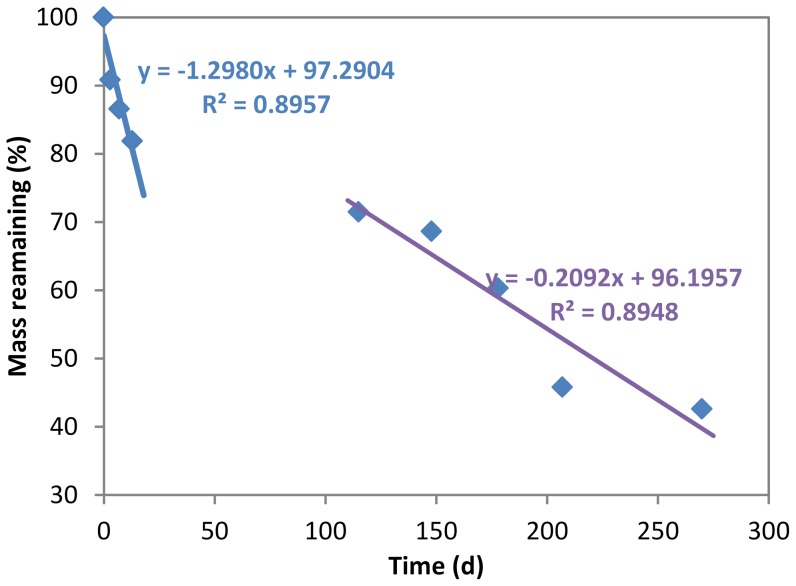
Detritus mass remaining of all the samples.Mean percentage of detritus mass remaining of all the samples during experimental period. The blue and purple solid lines are the linear regression lines for mass remaining at the early decomposition stage and the later decomposition stage, respectively.